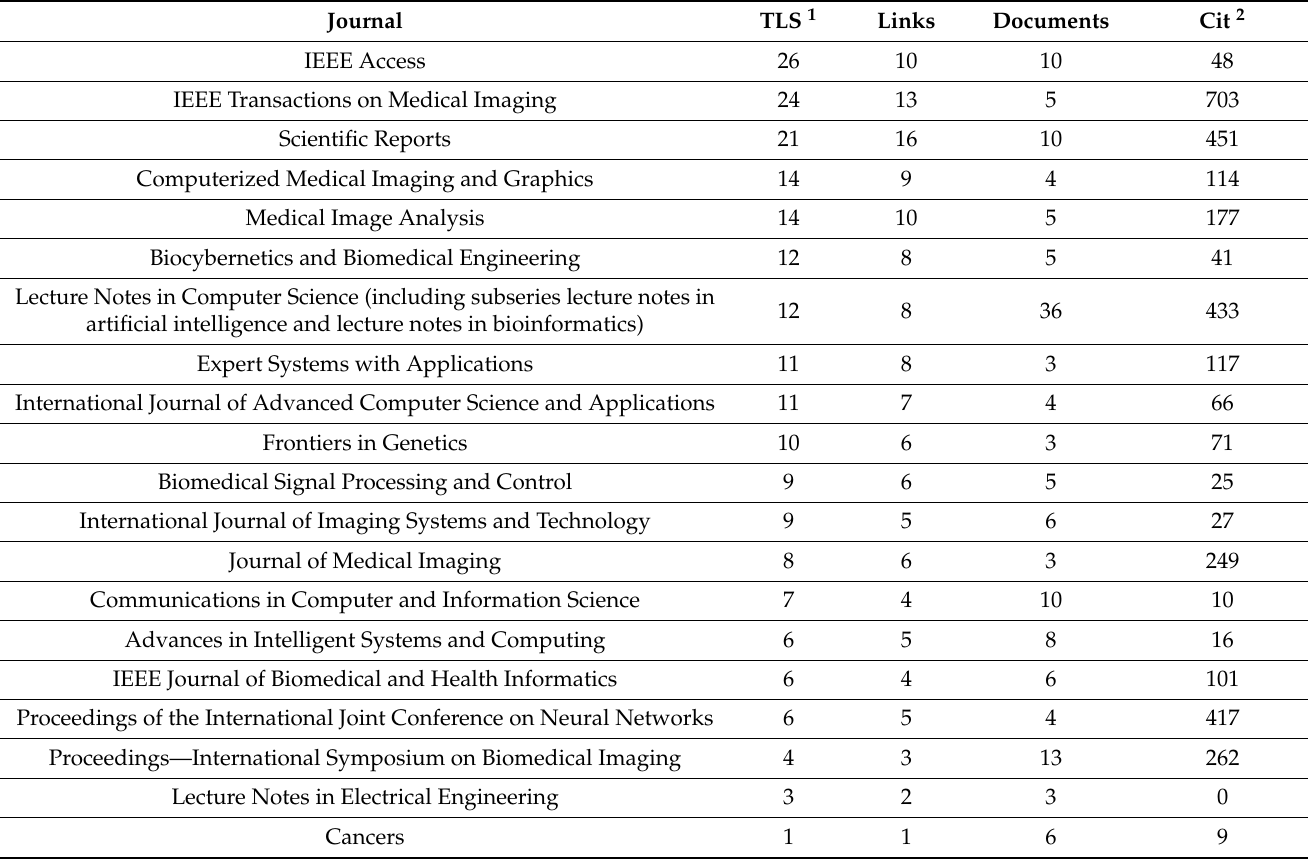
Table 6. Top 5 journals in publication for